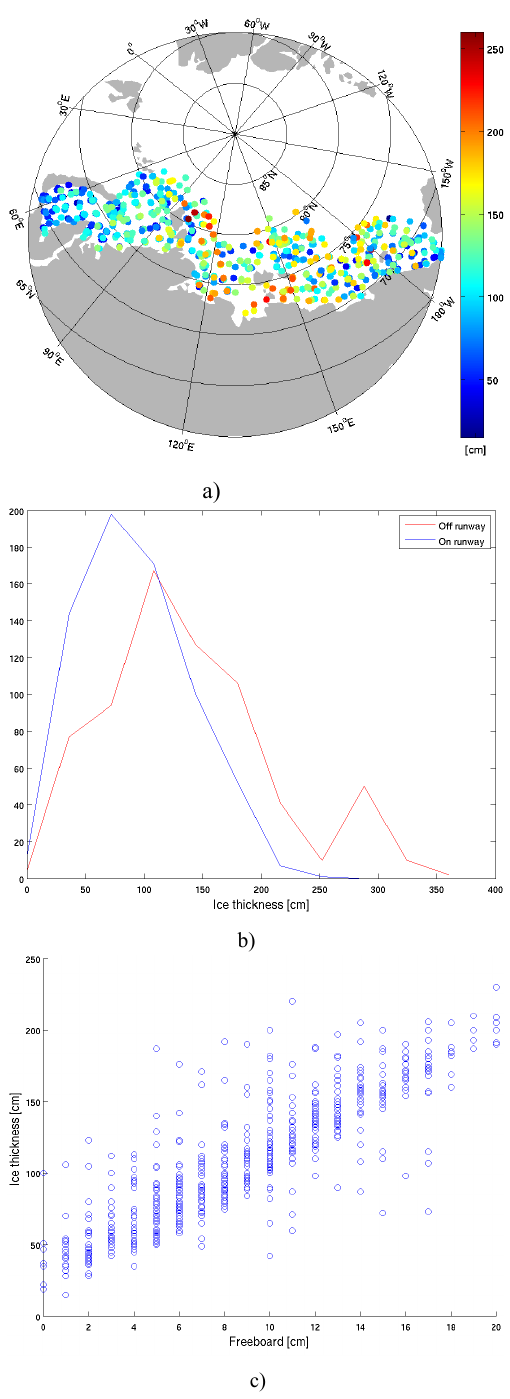
Fig. 1. a) Location of 689 ice thickness and freeboard measurements during the Sever aircraft Fig. 1. (a) Location of 689 ice thickness and freeboard measure- landings on the Arctic sea ice in 1980s, where colors indicate thickness of level ice on ments during the Sever aircraft landings on the Arctic sea ice in runways; b) histogram of ice thickness on level ice (on runway) and on characteristic ice types around the landing sites (off runway), c) a scatterplot of ice thickness versus ice 1980s, where colors indicate thickness of level ice on runways; freeboard measurements on level ice. (b) histogram of ice thickness on level ice (on runway) and on char- acteristic ice types around the landing sites (off runway), (c) a scat- terplot of ice thickness versus ice freeboard measurements on level